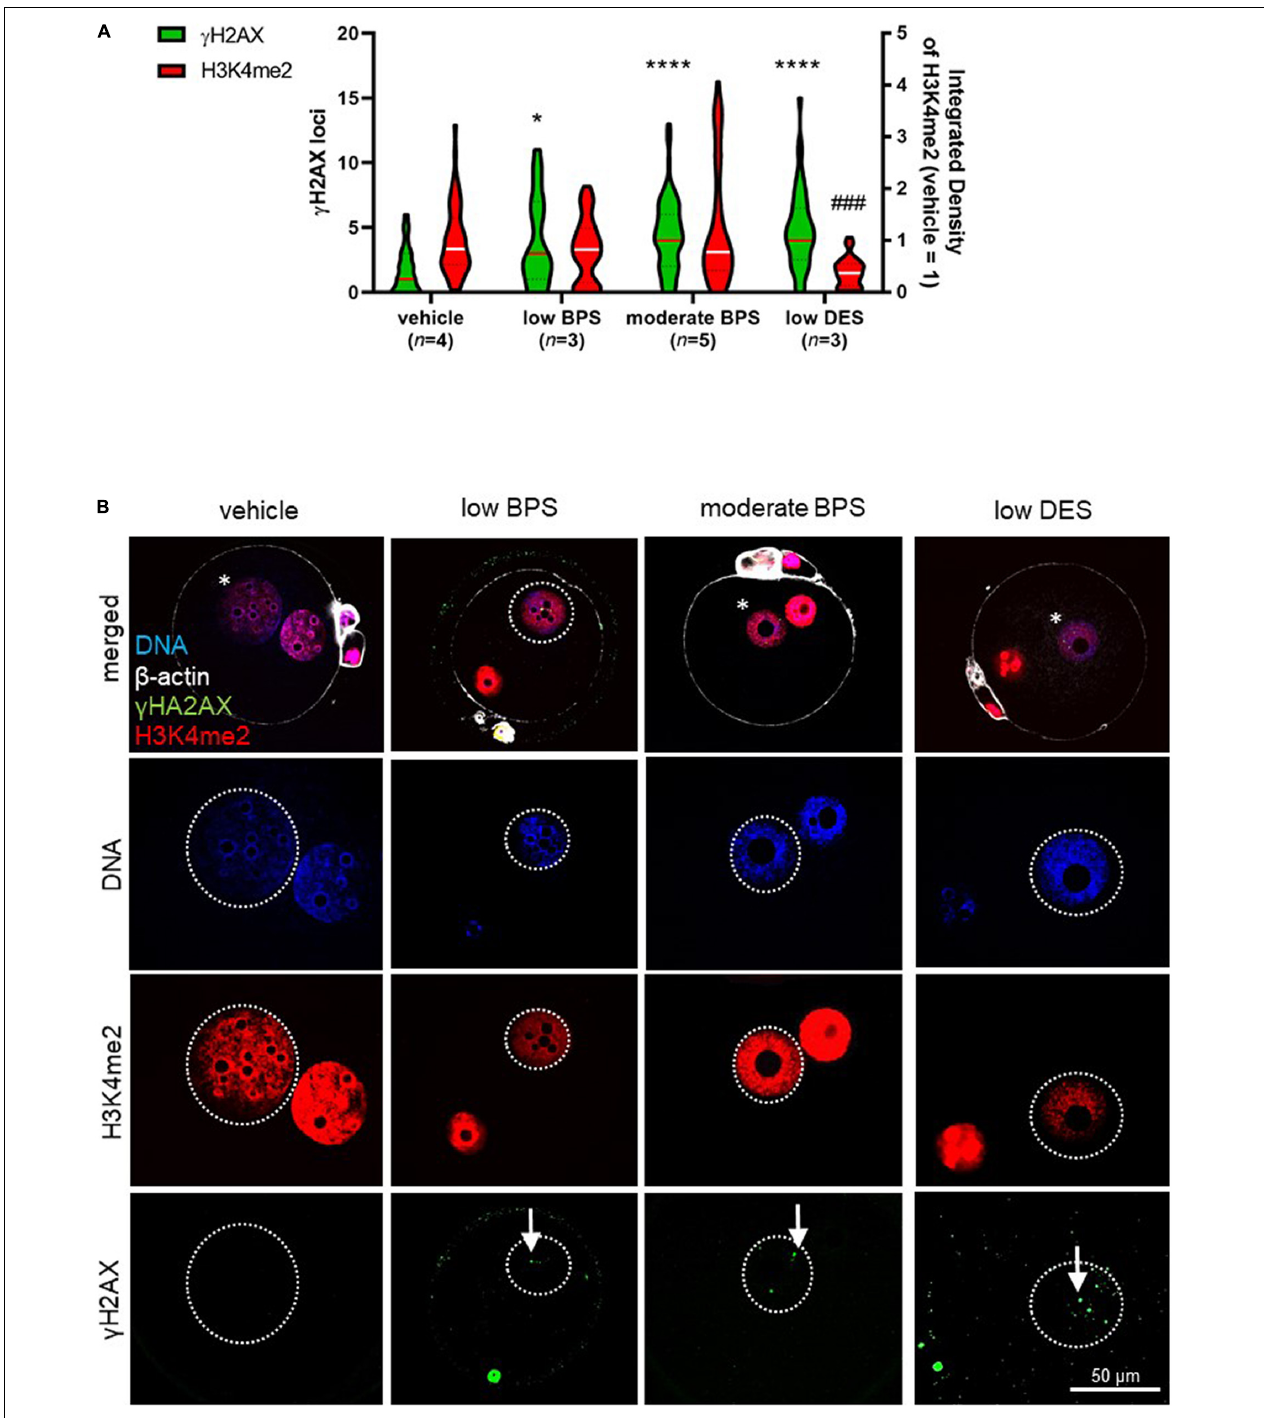
FIGURE 4 | Zygote quality after fertilization by bisphenol-affected spermatozoa. (A) Number of phosphorylation of histone H2 ( γ H2AX) loci in paternal pronuclei, in low and moderate BPS and low DES groups. Relative signal intensity of dimethylation of lysine (K4) on histone H3 (H3K4me2) in paternal pronuclei in zygotes of control, low and moderate bisphenol S (BPS) and low diethylstilbestrol (DES) groups. Integrated density was normalized to maternal values of the respective zygote. Violin plot shows the distribution of individual values (numbers of independent flushing sessions are indicated in brackets), lines represent the median, and dashed lines show quartiles. (B) Representative pictures of DNA, H3K4me2, and γ H2AX in zygotes. Comparison between experimental groups. Asterisks indicate paternal pronucleus. Arrows indicate γ H2AX loci. Differences were tested using the Kruskal-Wallis test, followed by Dunn’s multiple comparisons test. Statistical differences in γ H2AX loci and H3K4me2 integrated density are indicated by asterisks and daggers, respectively (* P < 0.05, **** P < 0.0001; ### P < 0.001). BPS: bisphenol S; DES: diethylstilbestrol.